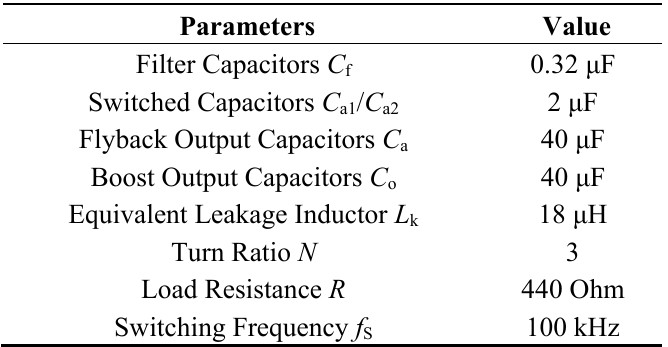
Table 2. Main parameters of the proposed converter.